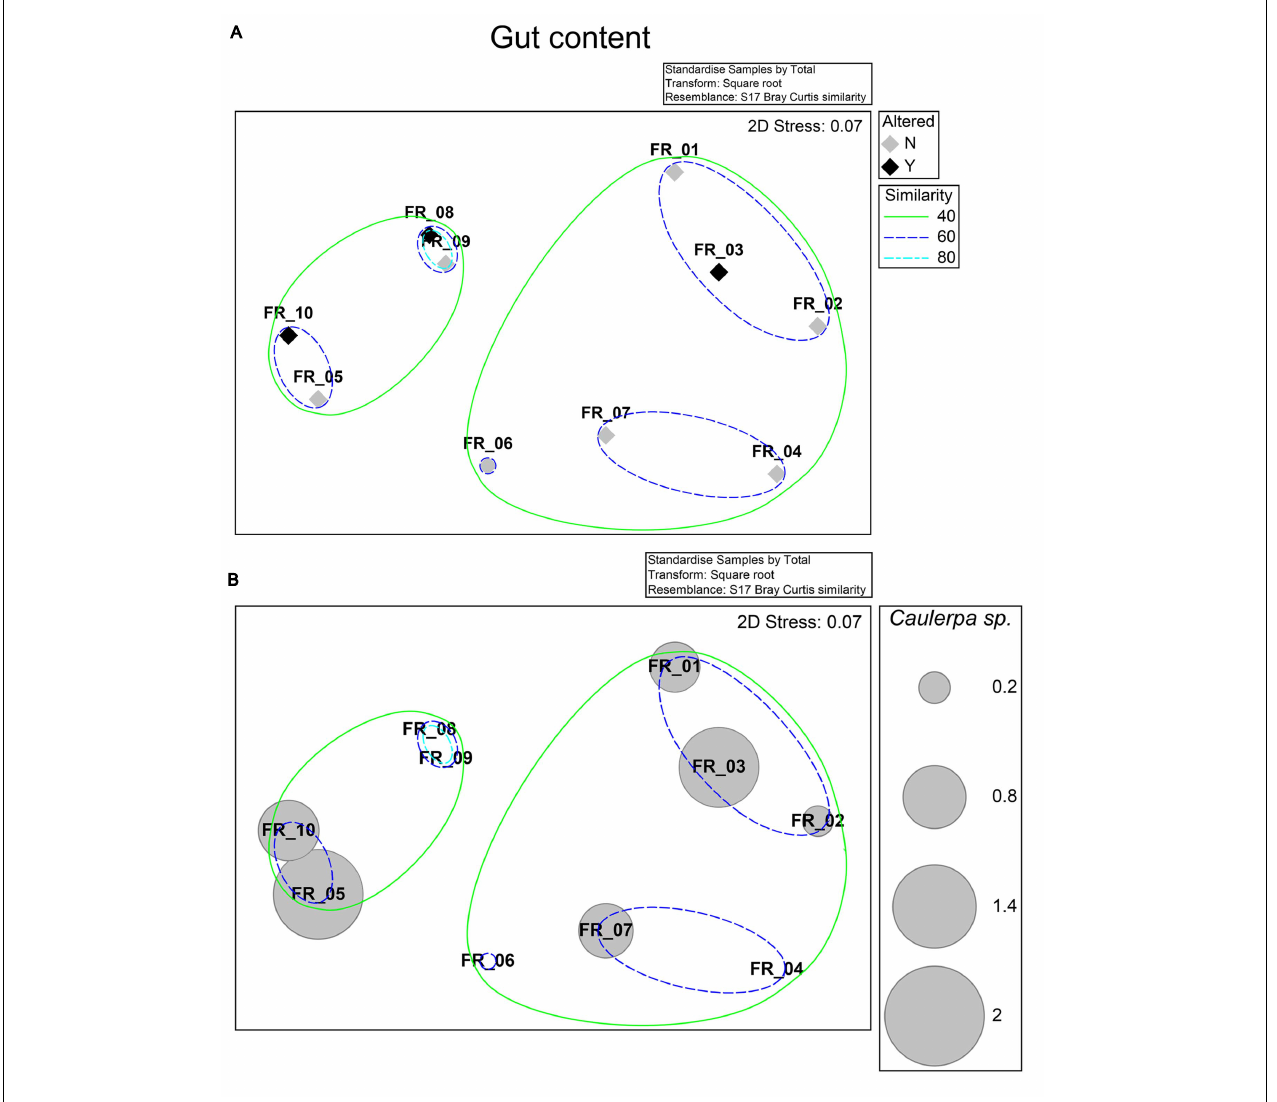
FIGURE 3 | nMDS ordination. Bray–Curtis similarity matrix from standardized and square root-transformed stomach content analysis was superimposed of the levels of the “Altered” factor and 40, 60, and 80% resemblances from a hierarchical cluster analysis (A) or the standardized relative stomach content percentage of Caulerpa sp. (B)